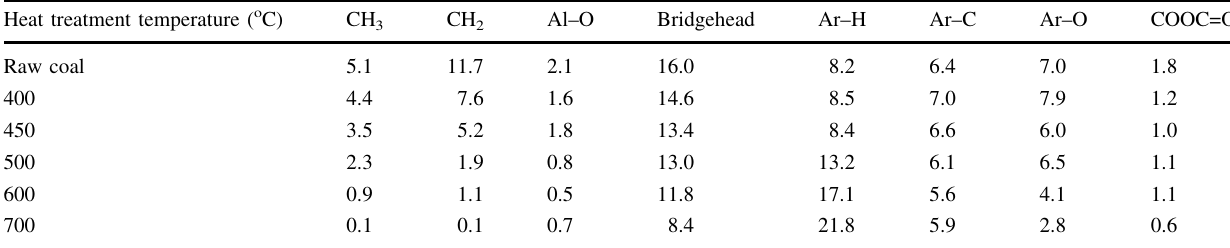
Table 2 Carbon distribution of coal AD, mmol/g-d Heat treatment temperature ( o C)